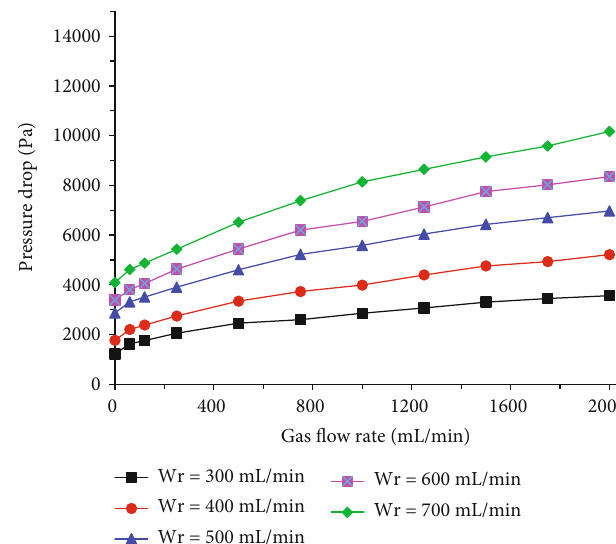
Figure 6: Evolution of the two-phase pressure drop with respect to the water fl ow rate and gas fl ow rate in case